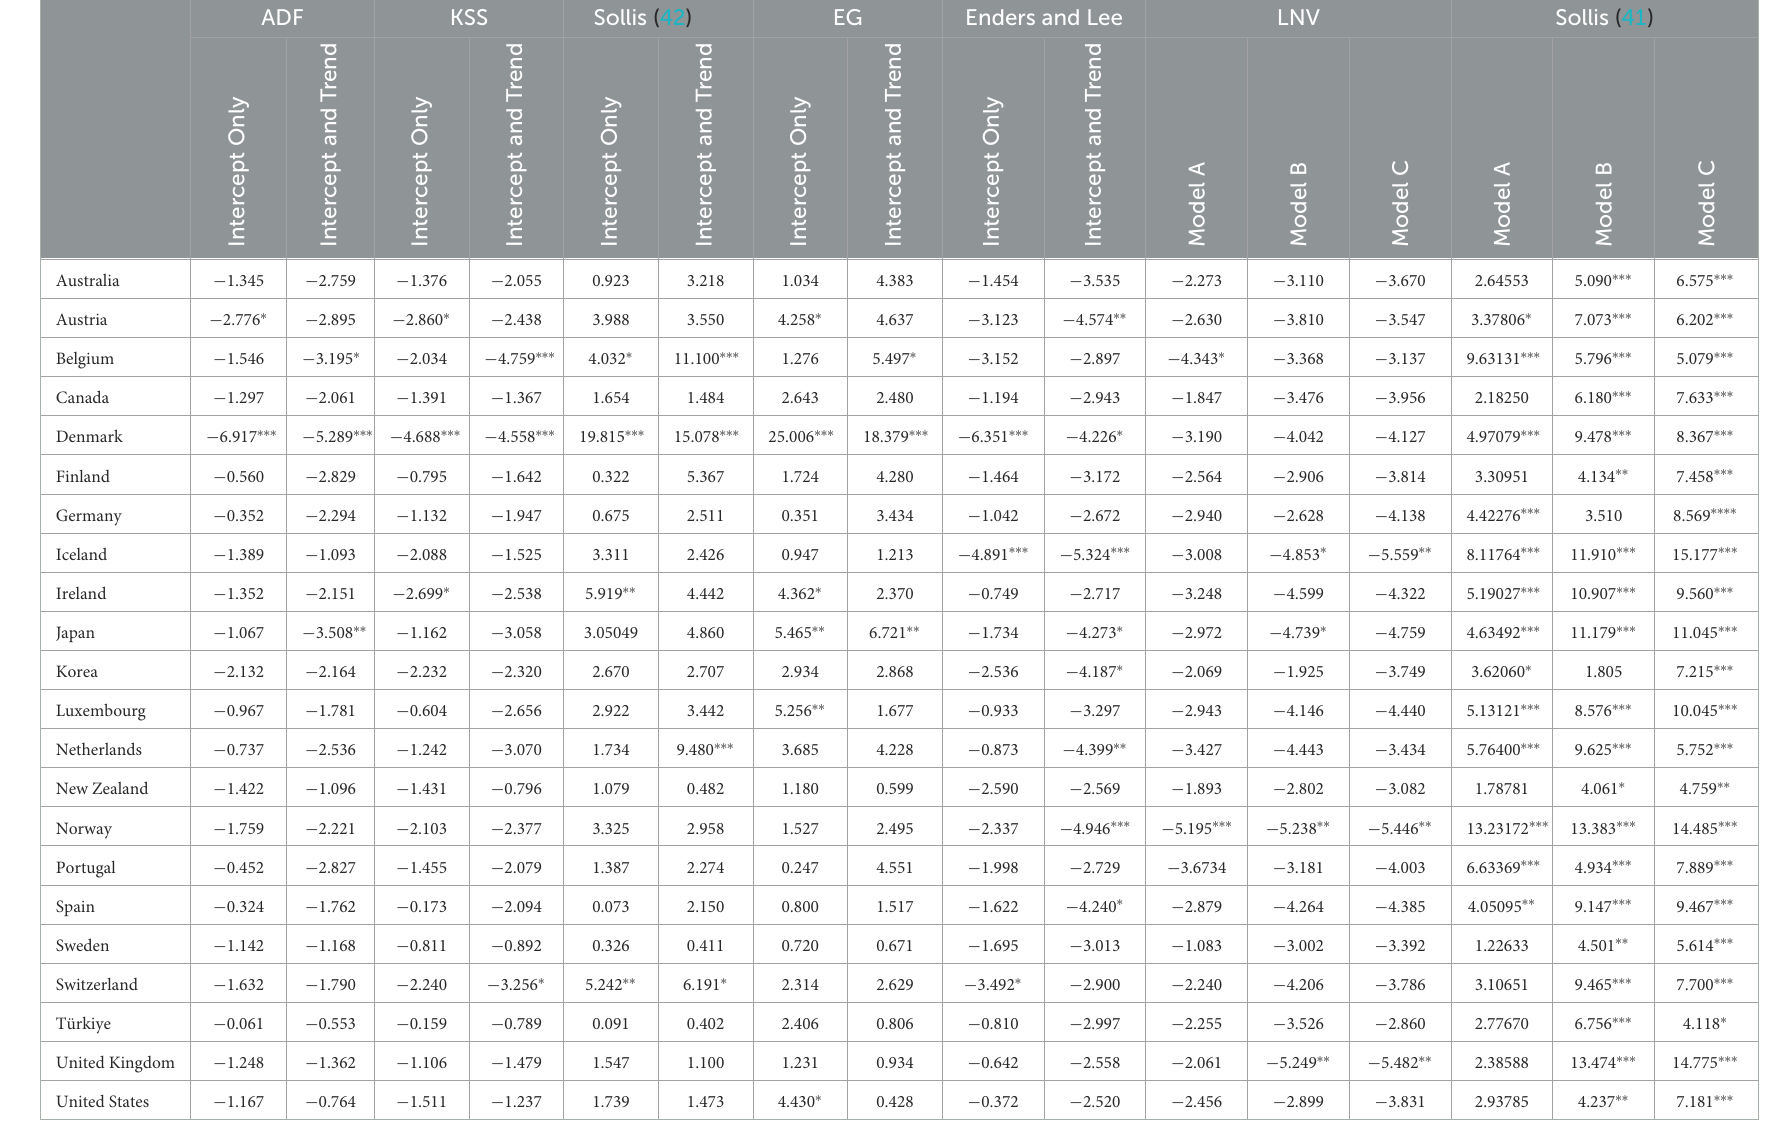
TABLE 1 Results of time series unit root tests–health expenditure per qualified